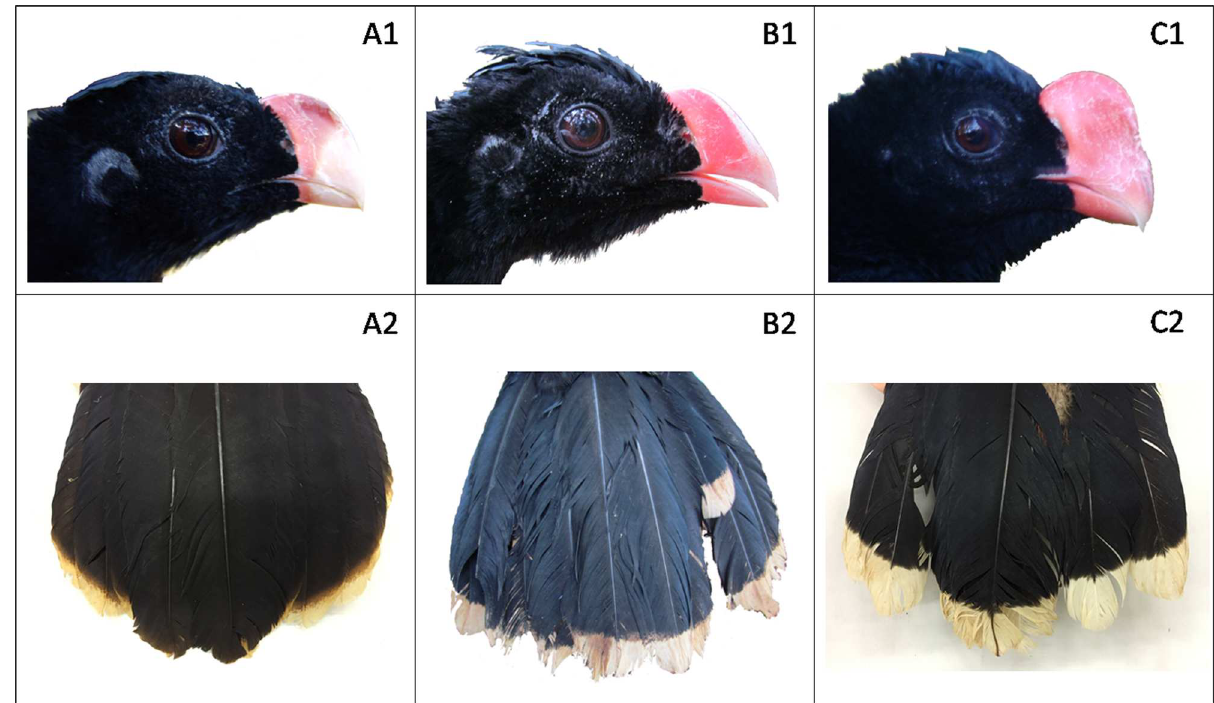
Fig 1. Diagnostic morphological characteristics of Alagoas Curassow. Pure AlagoasCurassow(A1 and A2), hybrid (B1 and B2), and Razor-billed Curassow(C1 and